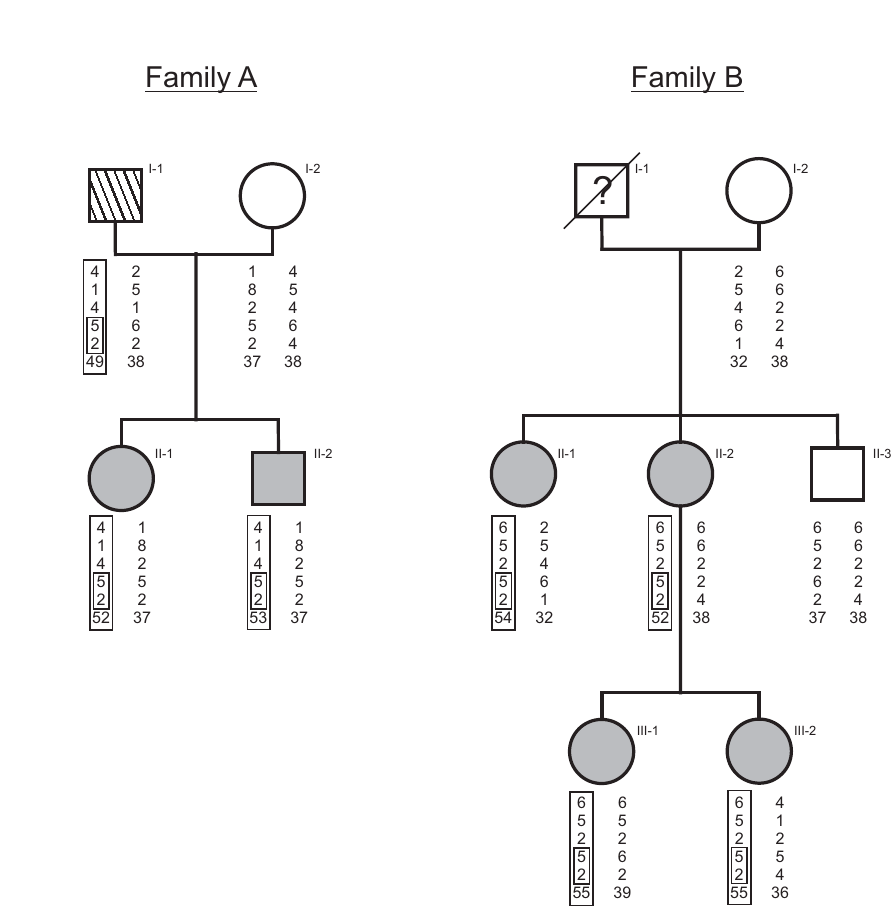
Figure 1 Pedigrees and haplotype analysis . Pedigrees of families A and B, including six-locus haplotypes based on five 6q-telomeric microsatellite markers (D6S1719, D6S264, D6S281, D6S446, D6S1590) and closely downstream located polymorphic poly-Gln encoding trinucleotide stretch within TBP . Alleles of the microsatellites are denoted by numbers 1 – 8, TBP alleles are denoted by the number of Gln-encoding trinucleotides. SCA17-linked alleles are boxed as well as the disease haplotype D6S446 and